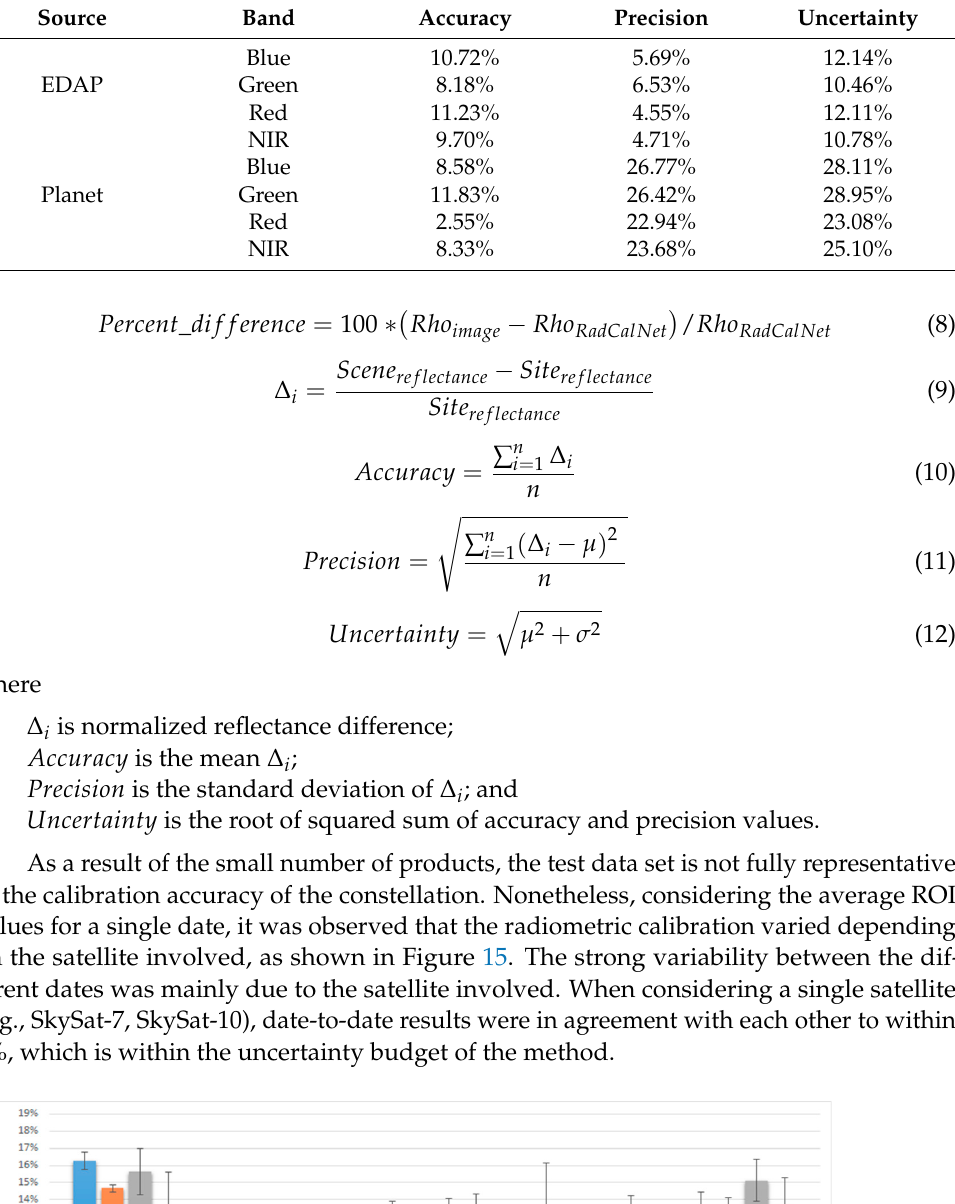
Table 6. The absolute radiometric calibration uncertainty results acquired over the Libya site.